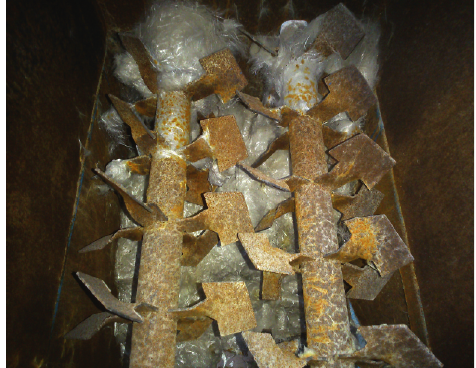
Figure 2: Stirring shaft of PVA fiber